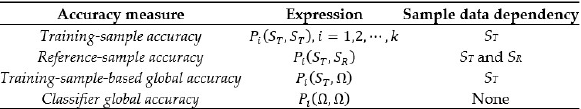
Table 1. Different measures of LULC classification accuracy. The training-sample-based global accuracy represents the classification accuracy of the thematic map. The training-sample accuracy, reference-sample accuracy and training-sample-based global accuracy all are dependent on the training dataset, and thus, conclusions of accuracy assessment using these measures are subject to the training data uncertainty. By contrast, the classifier global accuracy represents the accuracy achieved by using the population, i.e. the global dataset, to establish